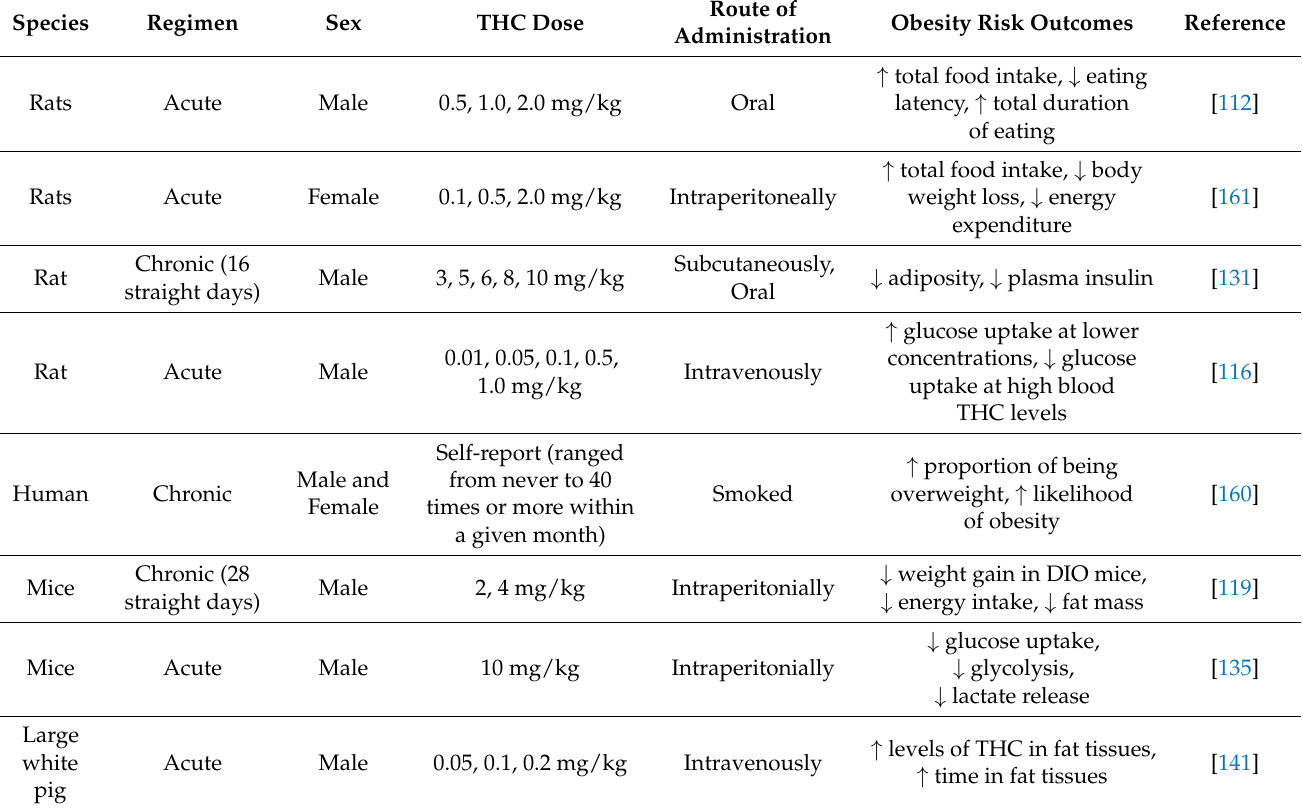
Table 2. A summary of preclinical and clinical studies in adolescent subjects treated with THC and the primary outcome that it had on inducing obesity-related symptoms. Included are an array of different obesity risk outcomes from THC use, including food intake, body weight, plasma insulin, and glucose uptake. The limited information in certain sources resulted in some of the information that would have been contained within the table being omitted. Route